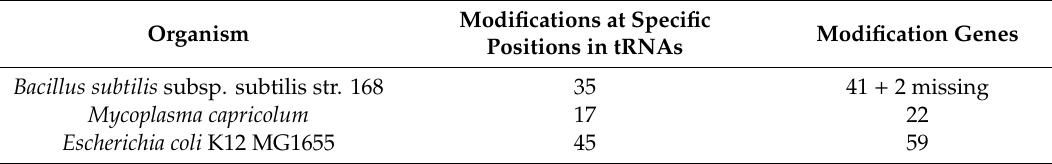
Table 3. Comparison of numbers of tRNA modifications and associated genes in three model organisms. Modifications at Specific Organism Modification Genes Positions in tRNAs Bacillus subtilis subsp. subtilis str.